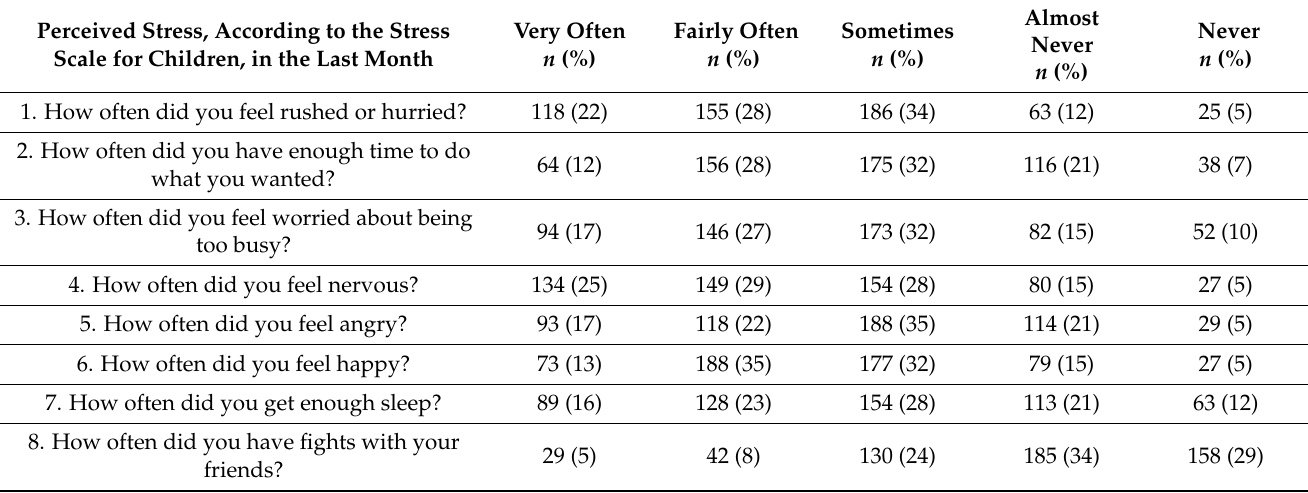
Table 3. The responses of participants to the Stress Scale for Children ( n =